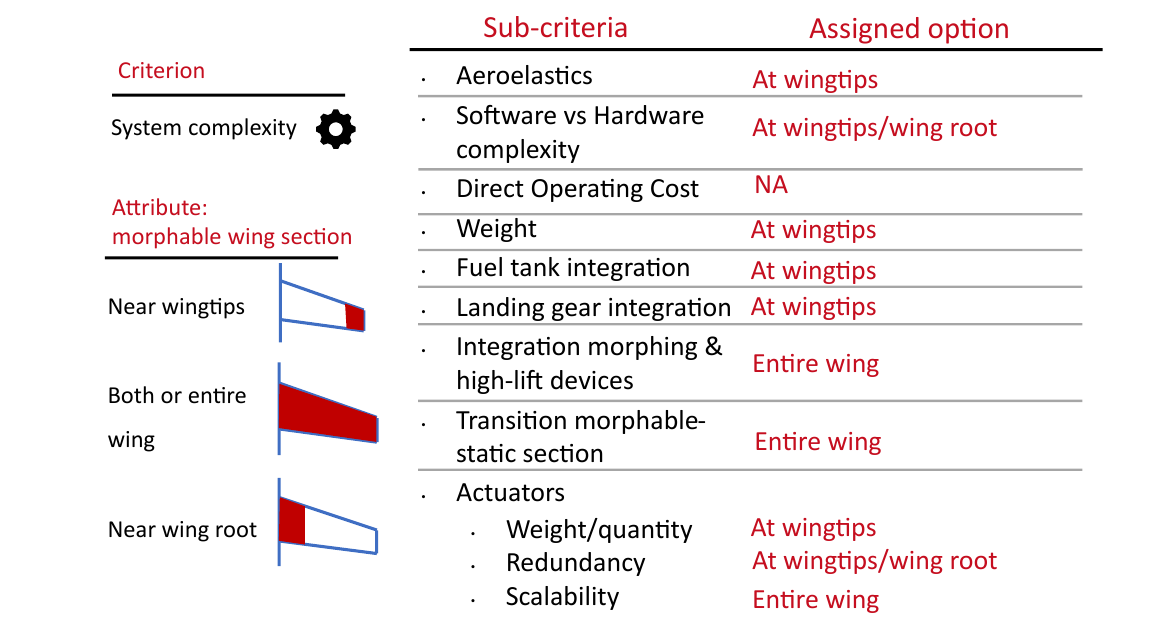
Figure 11. Option mapping of the morphable wing section attribute to the derived sub-criteria of the system complexity criterion. This mapping resulted from one of the group discussions during the second